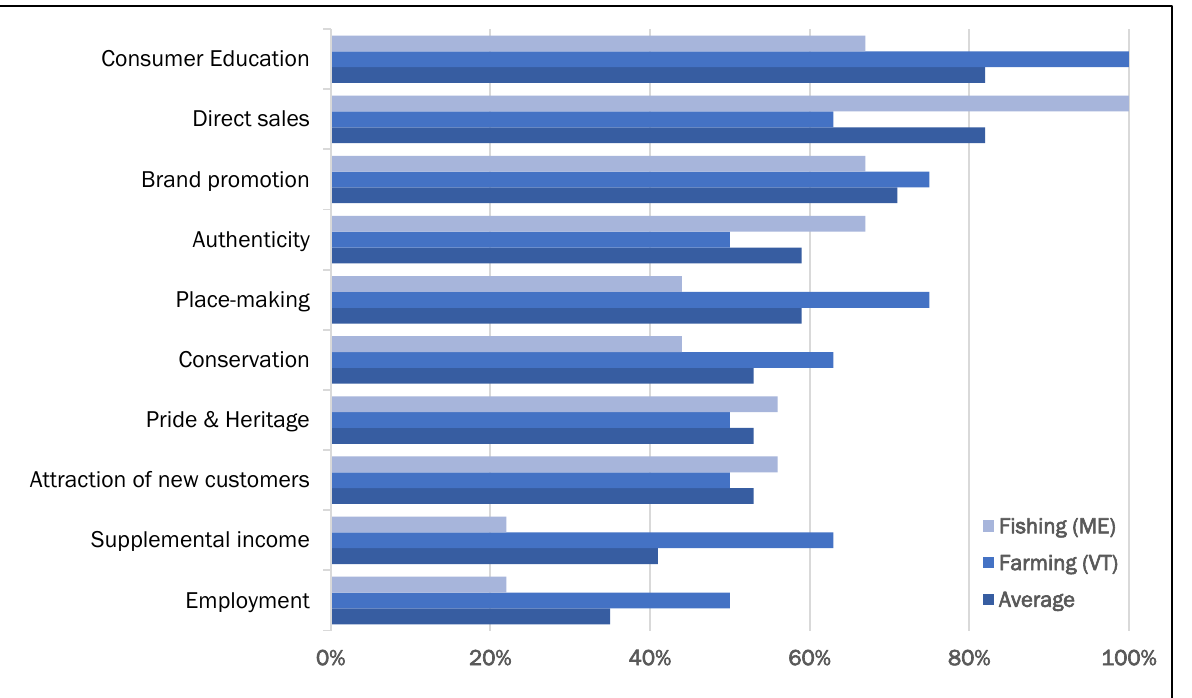
Figure 1. Economic and Non-Economic Benefits of Tourism Cited by